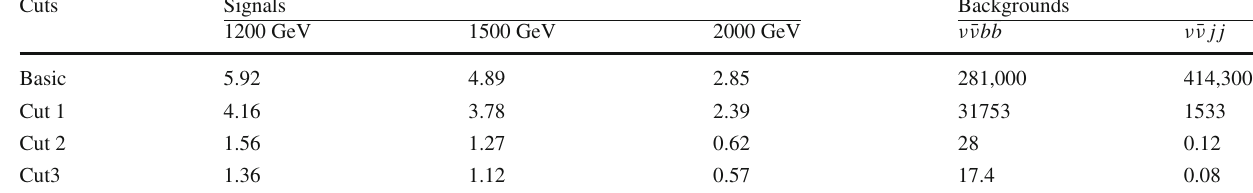
Table 2 Cut flow of the cross sections (in ab) for the signals and SM backgrounds at the CLIC with g ∗ = 0 . 1 and three typical VLQ- B quark